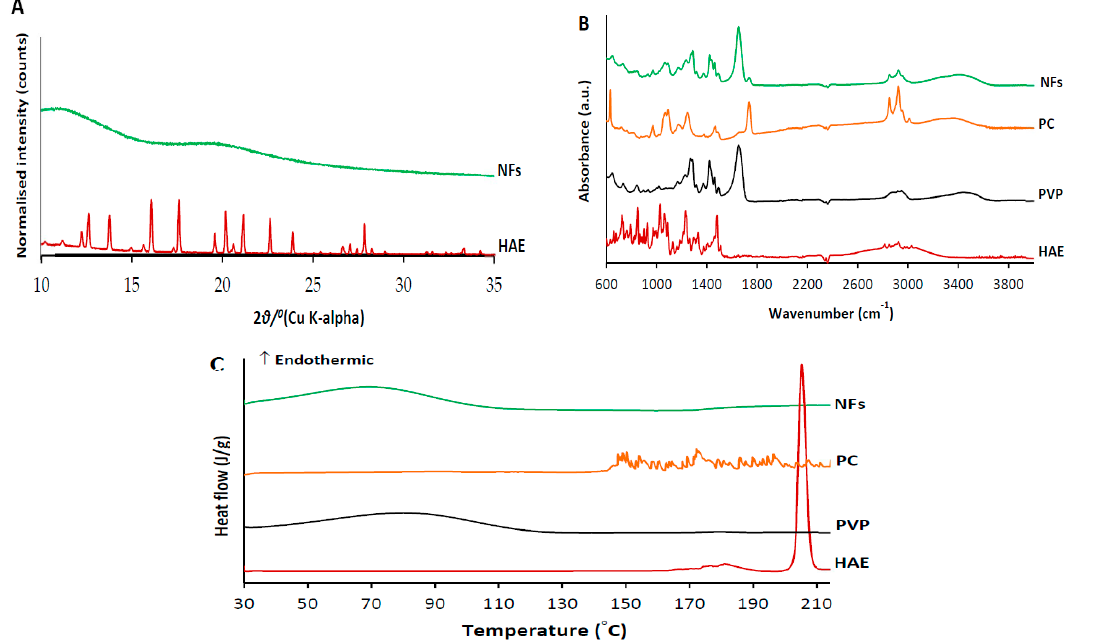
Figure 6. The XRPD patterns ( A ), FTIR spectra ( B ) and DSC thermographs ( C ) of HAE (as a powder form) and HAE-loaded amphiphilic electrospun NFs.